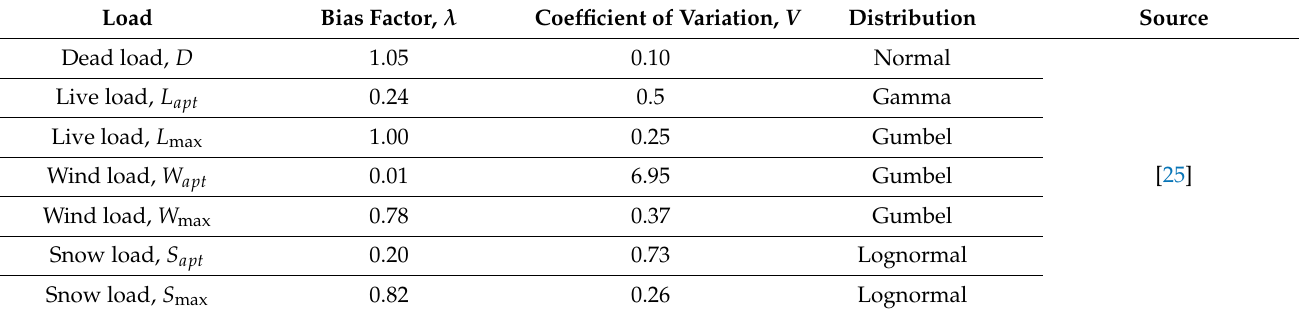
Table 4. Statistical parameters for the load effects (building